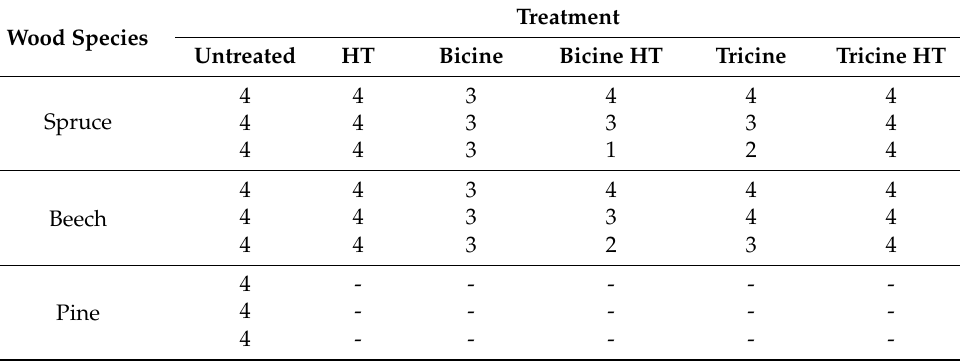
Table 2. Grade of termite attack for different wood species (pine, spruce, and beech) and the treatments: untreated, heat treated (HT), bicine, bicine and heat treatment (Bicine HT), tricine, tricine and heat treatment (Tricine HT), after four weeks of exposure, for each replicate. The wood blocks were graded using the scale: 0 = no damage; 1 = attempted attack; 2 = slight damage; 3 = superficial and inner damage; 4 = heavy inner damage